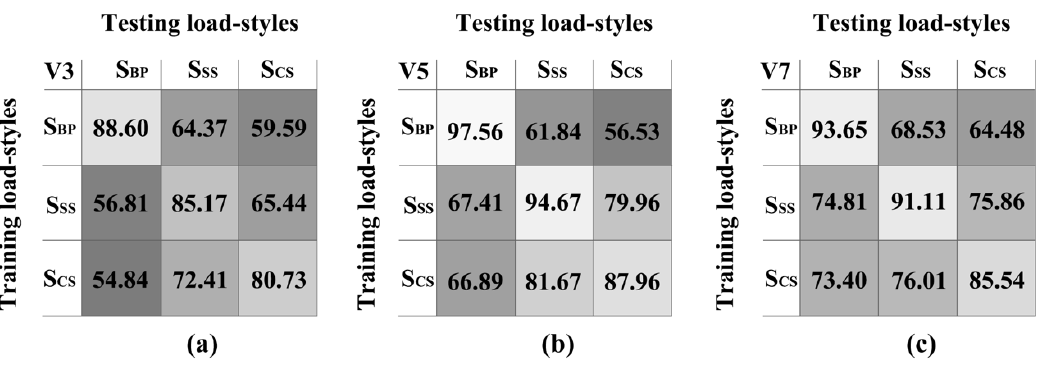
Figure 4. Gait recognition (%) matrices under three speeds (V3 ( a ), V5 ( b ) and V7 ( c )). Each entry value in the matrix represents a gait recognition performance (%) from the indicated training load style (vertical axis) and testing load style (horizontal axis). A lighter colour means better performance.